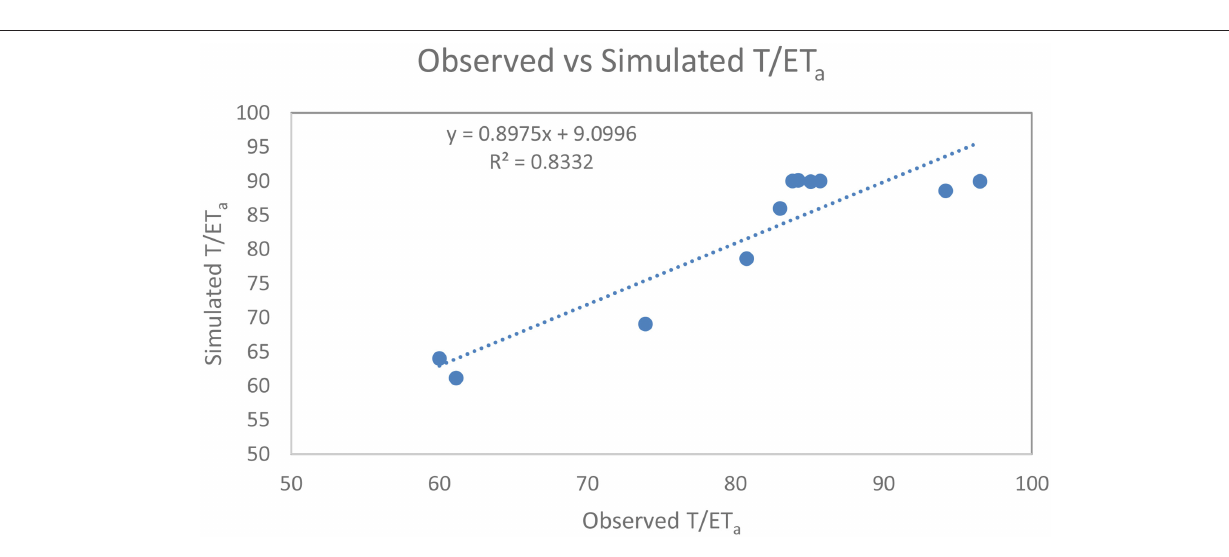
FIGURE 5 | Relationship between the observed and simulated winter wheat transpiration (T)/actual evapotranspiration (ET a